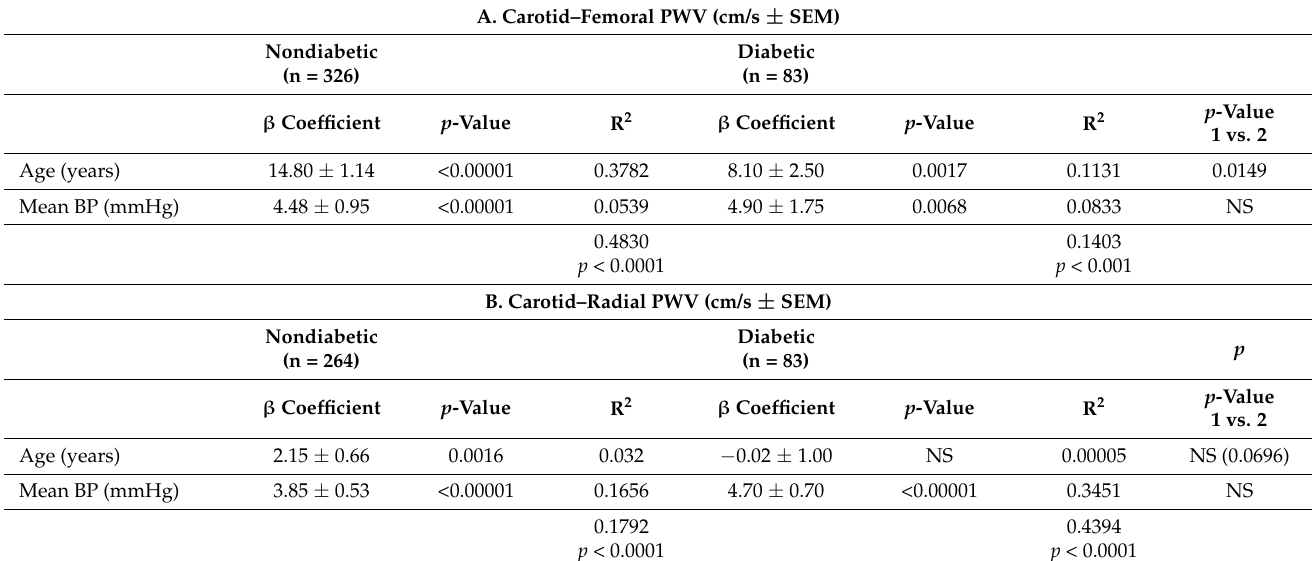
Table 2. Multiple regression report of factors associated with pulse wave velocity in central elastic and peripheral muscular arterial segments in nondiabetic and diabetic end-stage renal disease pa- tients.